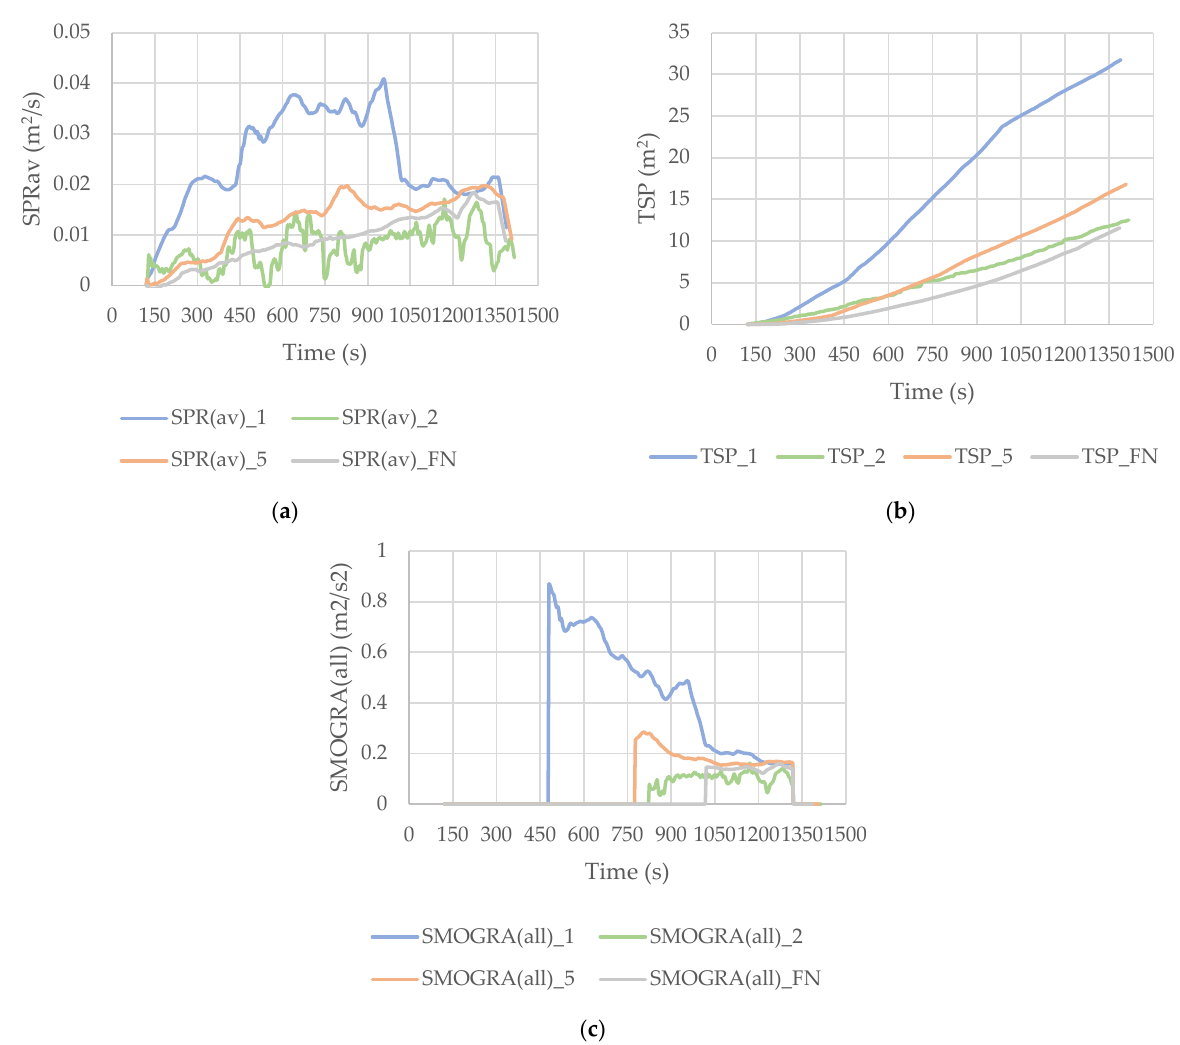
Figure 7. Test results from smoke production test to the uncoated samples (1, 2, 5, and FN) as specified by BS EN 13823 [13]: ( a ) Average of smoke production rate of the specimen (SPRav(t)); ( b ) Total smoke production of the specimen (TSP(t)); ( c ) Smoke growth rate of the specimen.